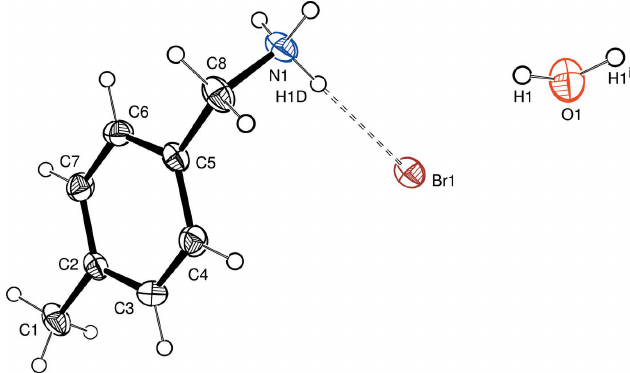
Figure 1 A view of (I), with displacement ellipsoids drawn at the 30% probability level. H atoms are represented as small spheres of arbitrary radii. Hydrogen bonds are shown as dotted lines. [Symmetry code: (i) 1 (cid:3) x , y ,